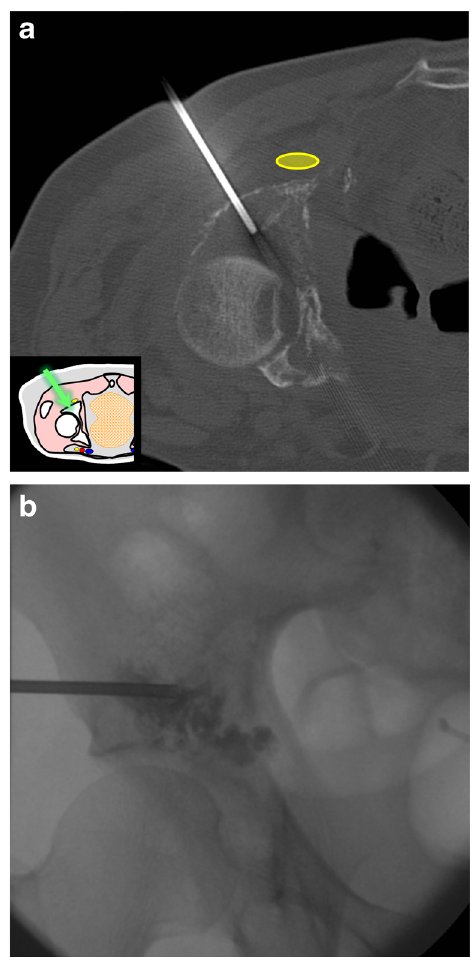
Fig. 16 A 70-year-old man treated for metastatic bladder carcinoma and presenting with severe hip pain. a A posterior approach for acetabular cementoplasty with an 11-G bone needle was used for pain control and stability. b PA fluoroscopic view is used during injection to control the real-time cement distribution in the Z -axis. In this specific location, par- ticular attention should be paid for cement leakage into the joint